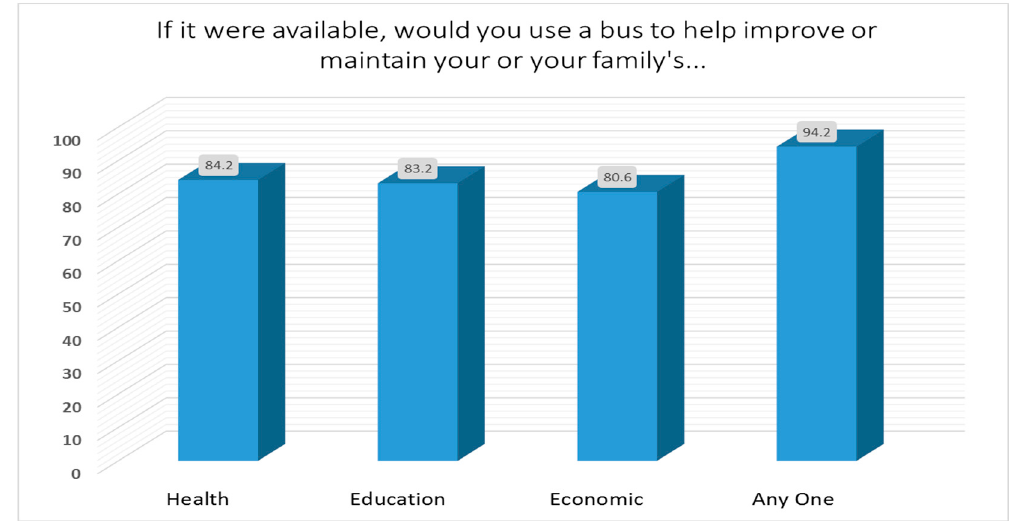
Figure 2. Percentage of respondents who would use the bus service.